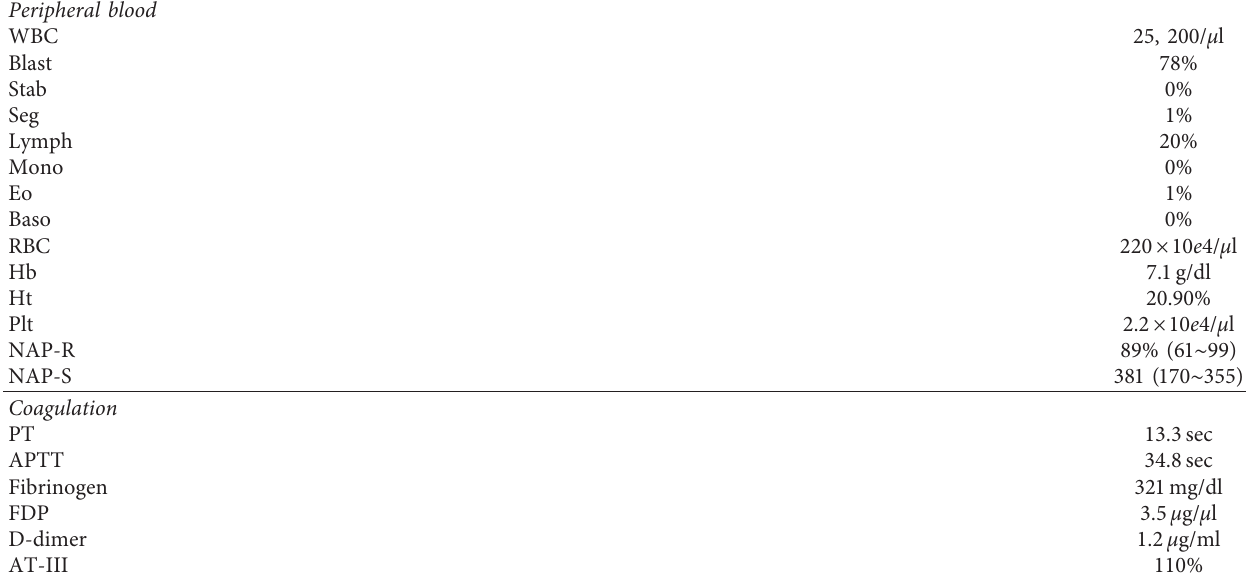
Table 1: Laboratory findings on